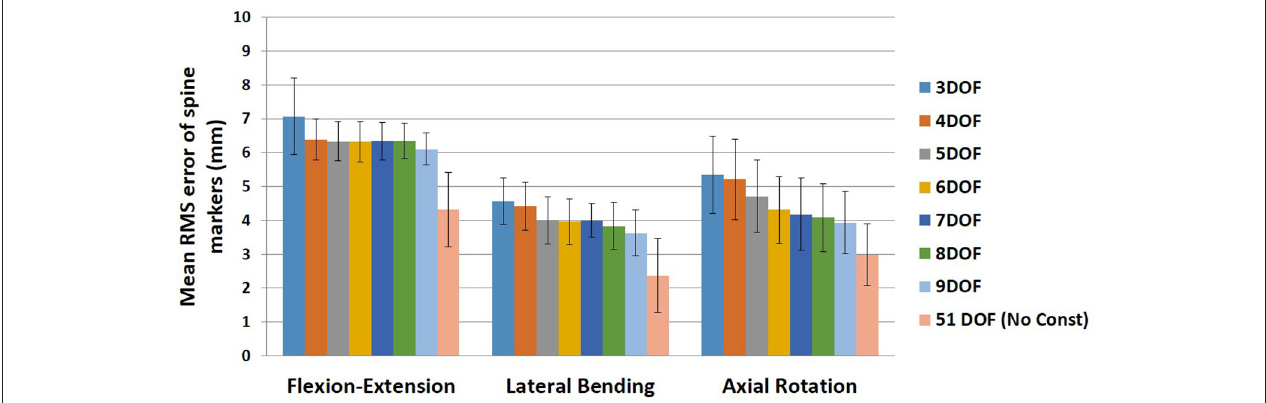
FIGURE 1 | Mean RMS error of spine markers for all kinematic constraints (3–9DOF) and no constraint condition (51DOF) in all tasks (flexion–extension, lateral bending, and axial rotation). Error bars indicate the SDs. RMS, root mean square; DOF, degrees of freedom.